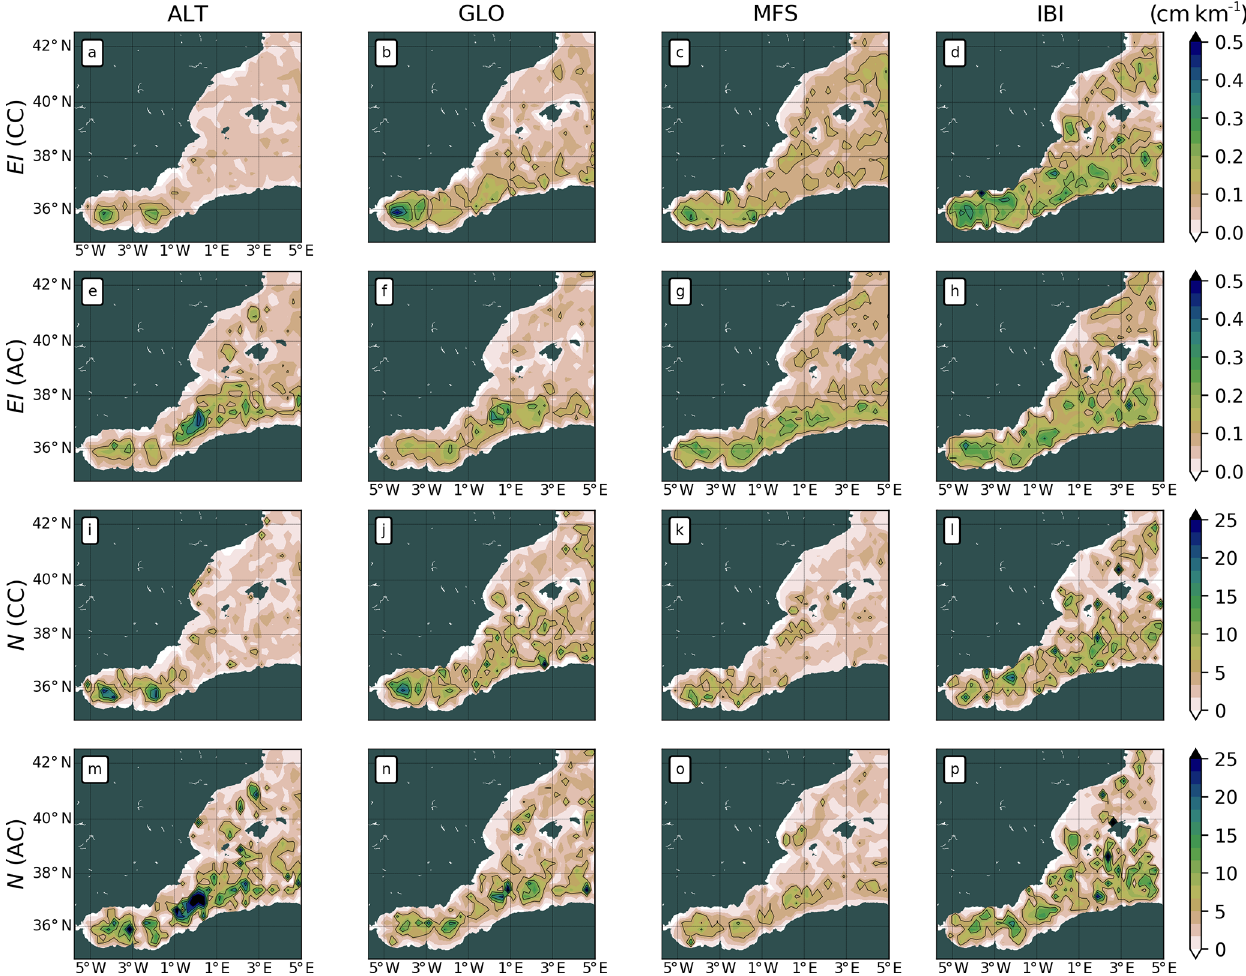
Figure 5. Maps of mean eddy intensity (a–h) and nonlinearity (i–p) over the western Mediterranean. Columns for ALT, GLO, MFS and IBI. Paired rows for cyclones (CC) and anticyclones (AC). Maps of the numerator ( U ) and denominator ( c ) for nonlinearity in (i) through (p) are shown in Fig.